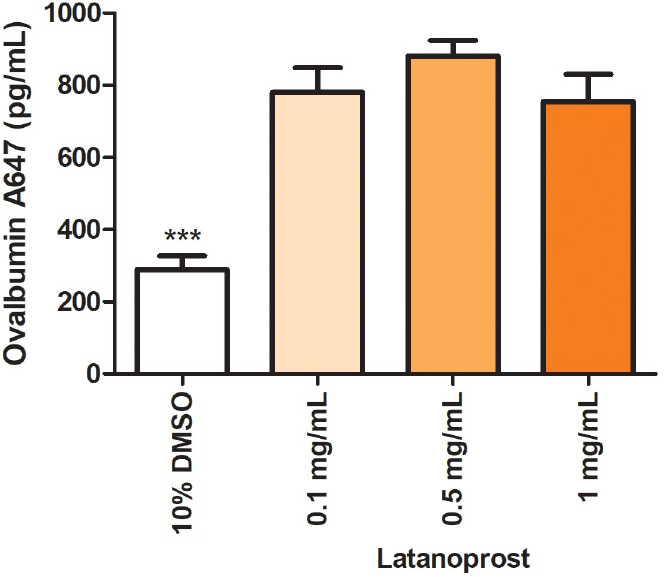
Fig 4. Evaluation of tracer recovery from the nasal turbinates of animals treated with daily doses of latanoprost over 3 days (4 animals treated with 0.1 mg/ml; 5 each with the other two doses). Nasal turbinates were isolated 1 hour after ventricular tracer injection and between 7 and 9 hours after the final latanoprost dose was given intranasally; � = p < 0.01 relative to control.